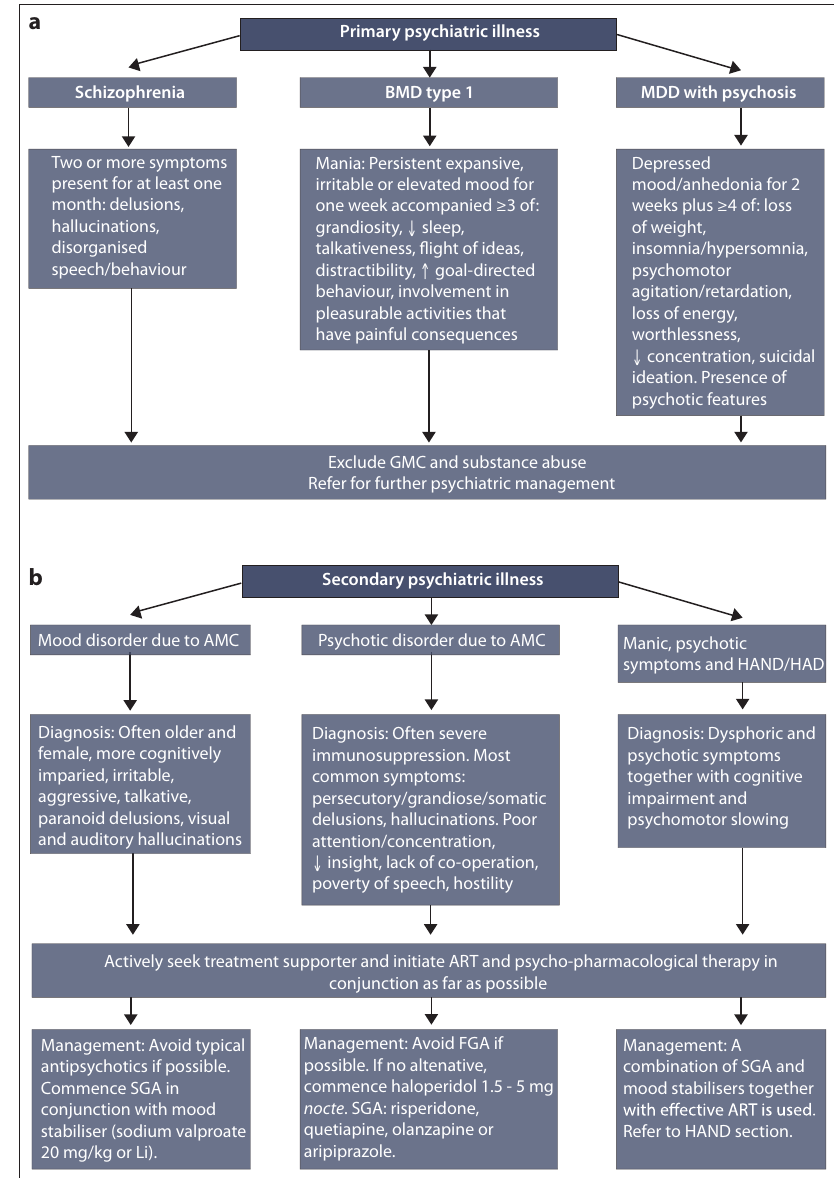
Fig. 4. Recognising (a) primary and (b) secondary SMDs. (BMD = bipolar mood disorder; SMD = severe